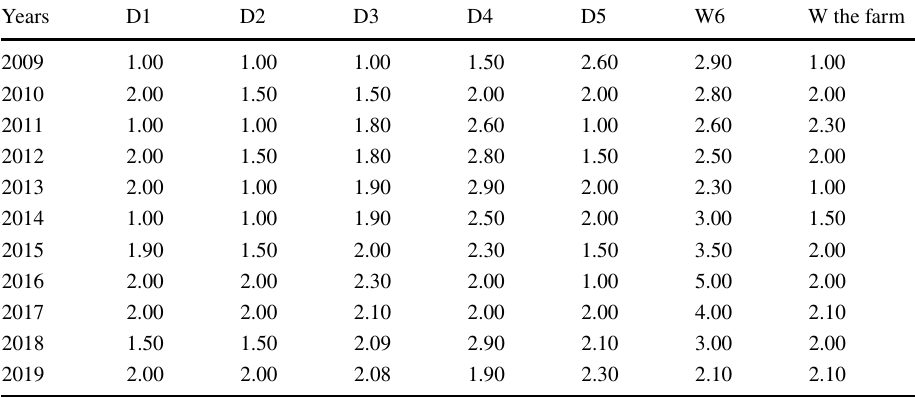
Table 8 Potassium (mg/l) values of water points in the Mougheul area